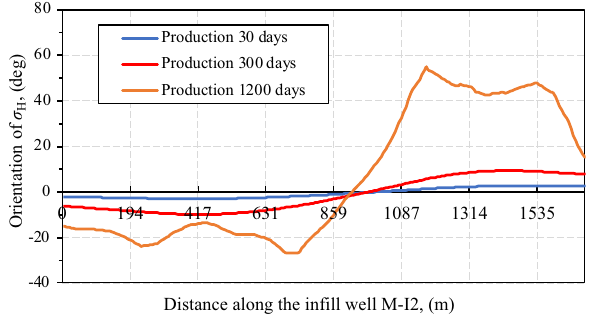
Fig. 7 Pressure and stress fields after the phase two production: a formation pressure p ; b minimum horizontal stress σ mum horizontal stress σ H